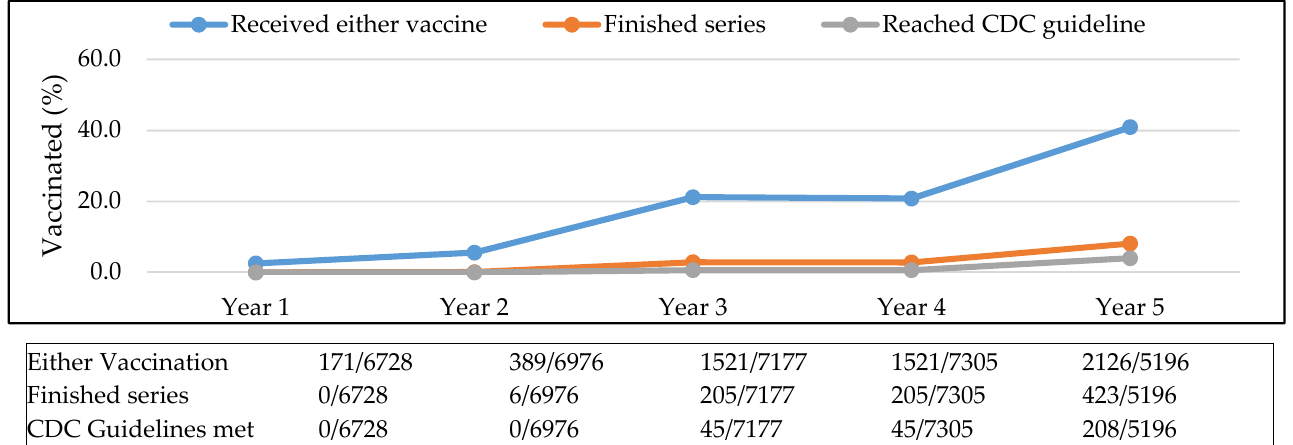
Figure 2. Yearly rate of vaccination. Abbreviations used: PPSV23: pneumococcal polysaccharide vaccine; PCV13: pneu- mococcal conjugate vaccine.